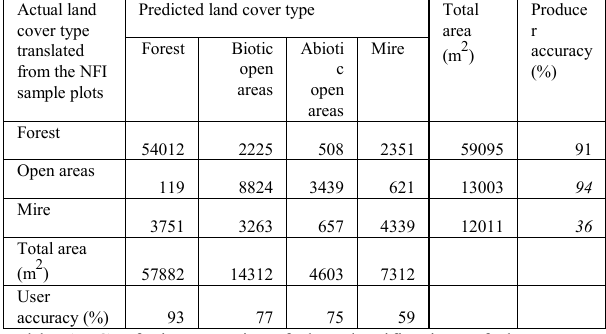
Figure 3. An example of an image tile segmented using the multiresolution algorithm